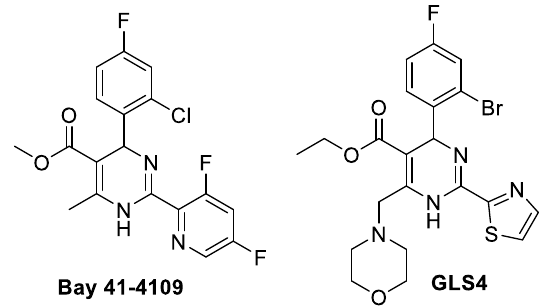
Figure 1. Structures of capsid assembly modulators: Bay 41-4109 and GLS4 [18].